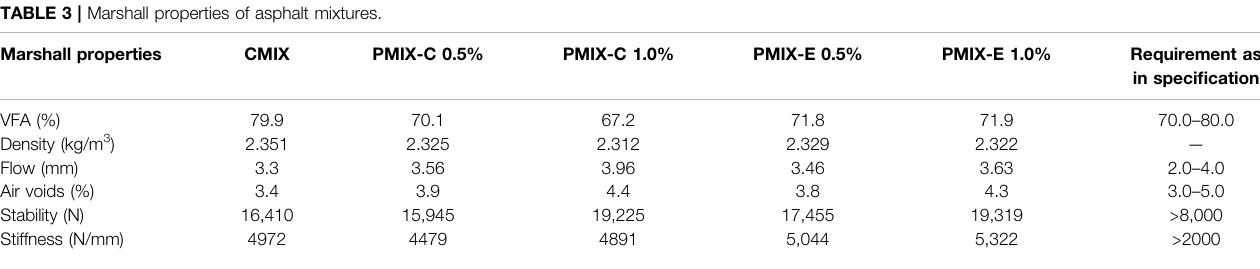
TABLE 3 | Marshall properties of asphalt